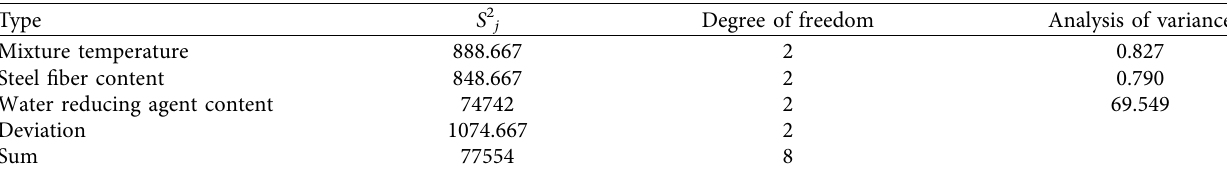
Table 4: Variance analysis table of the effect of mixing temperature, steel fiber, and water reducer dosage on slump.